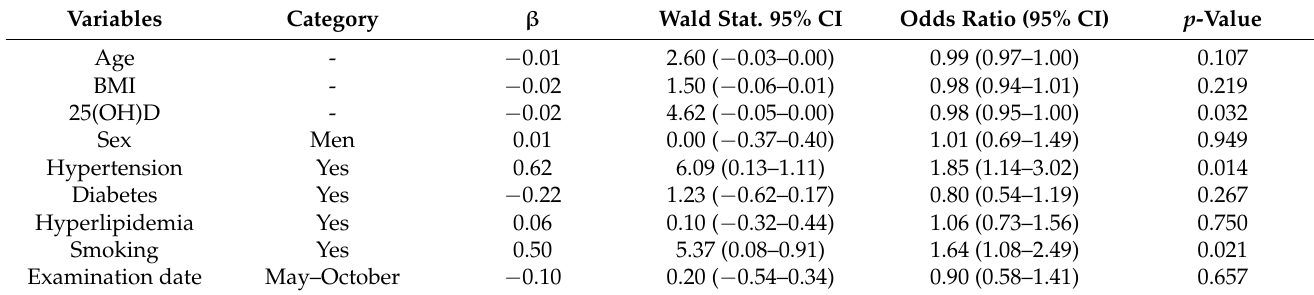
Table 3. Multivariable logistic regression analysis of factors associated with ACS